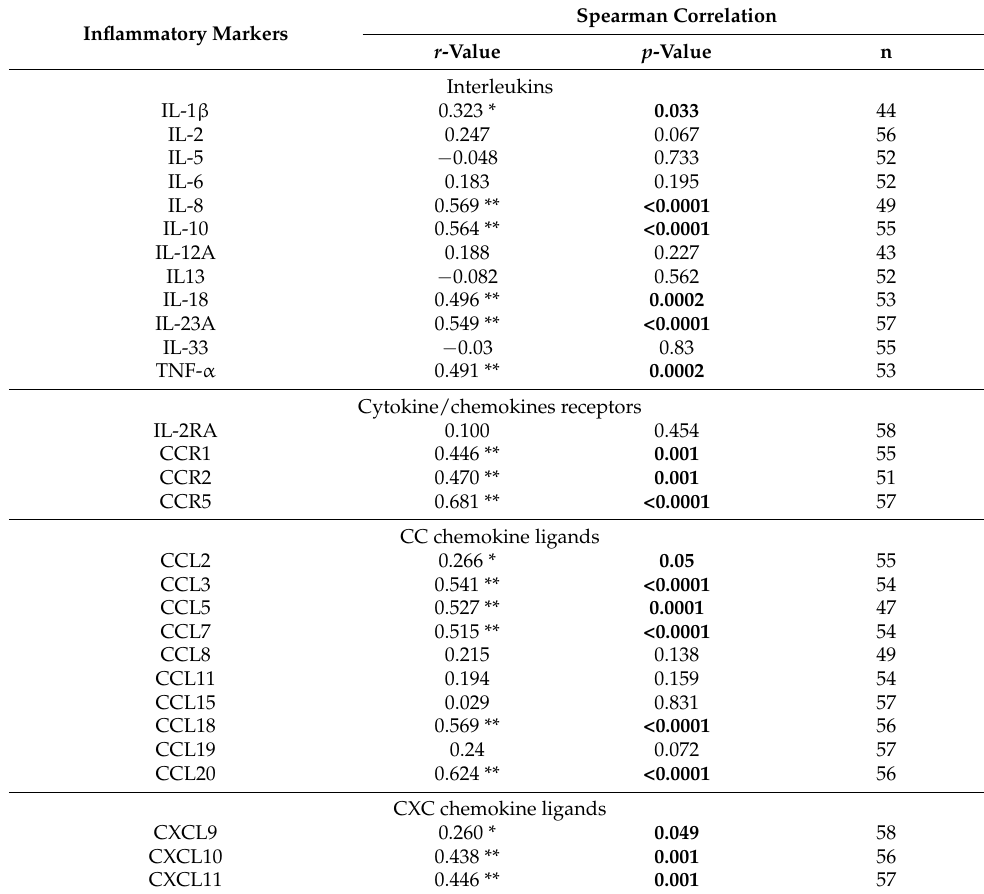
Table 2. Correlation of AT dectin-1 gene expression with that of various cytokines/chemokines and their cognate